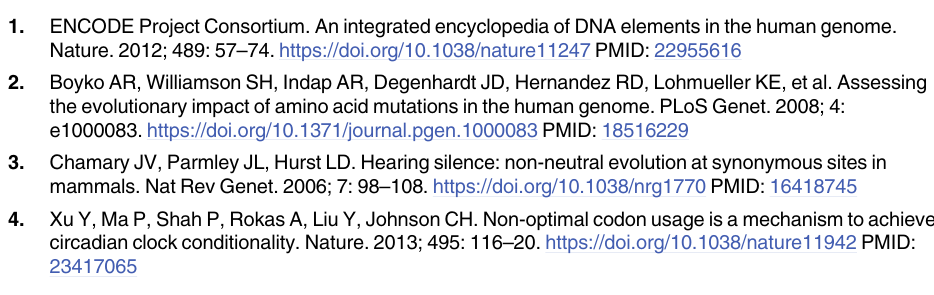
S2 Table. Frequency of observed small-conductance openings of T2562G-CFTR. S3 Table. Frequency of usage of different codons in CFTR compared to their usage in the human